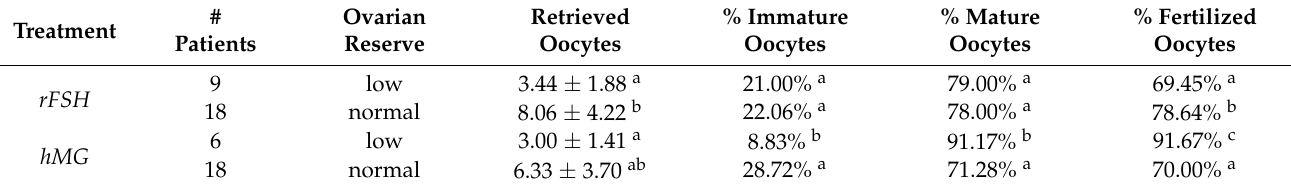
Table 1. Summary of patients’ data: number of average retrieved oocytes, percentage of immature, mature, and fertilized oocytes. Data of number of retrieved oocytes are reported as mean ± standard deviation. Different letters indicate a statistically significant difference ( p < 0.05) and are calculated by ANOVA followed by Tukey’s multiple comparisons test (average retrieved oocytes) and by Chi square test (% immature, % mature oocytes, and % fertilized oocytes).